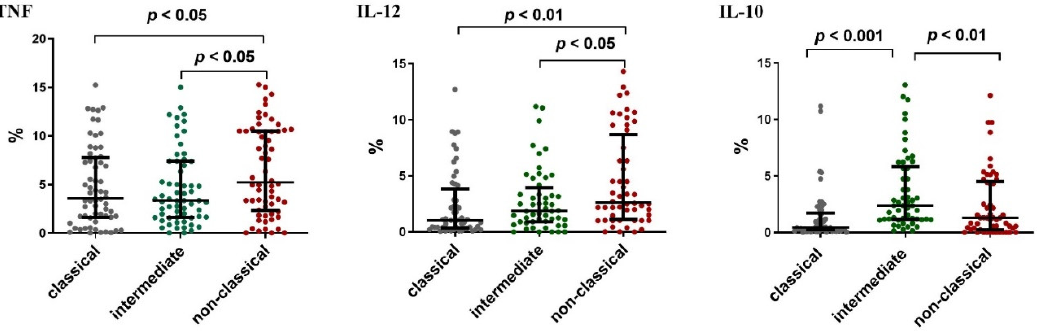
Figure 8. Percentage of classical (CD14 + CD16 − SLAN − ), intermediate (CD14 + CD16 + SLAN − ) and non-classical monocytes (CD14 dim CD16 + SLAN + ) assessed for intracellular expression IL-10, TNF and IL-12 in “ex vivo” conditions. The solid line marks the median value. Ɪ represents the interquartile range (IQR).